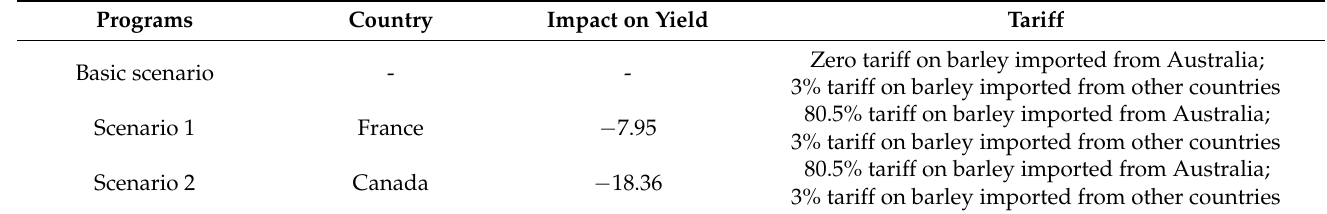
Table 4. Design of the extreme natural disaster simulation